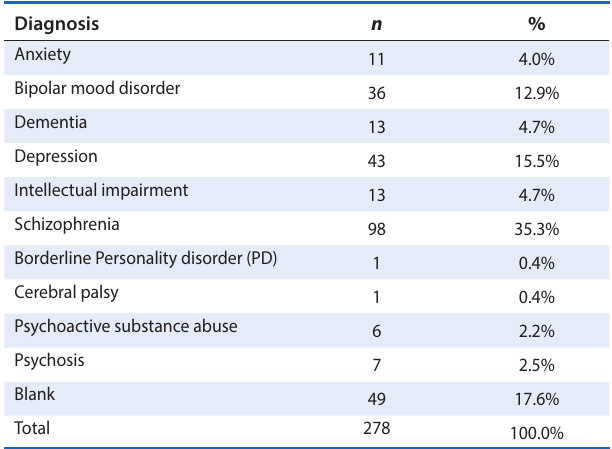
Table 1: Rates of mental disorder